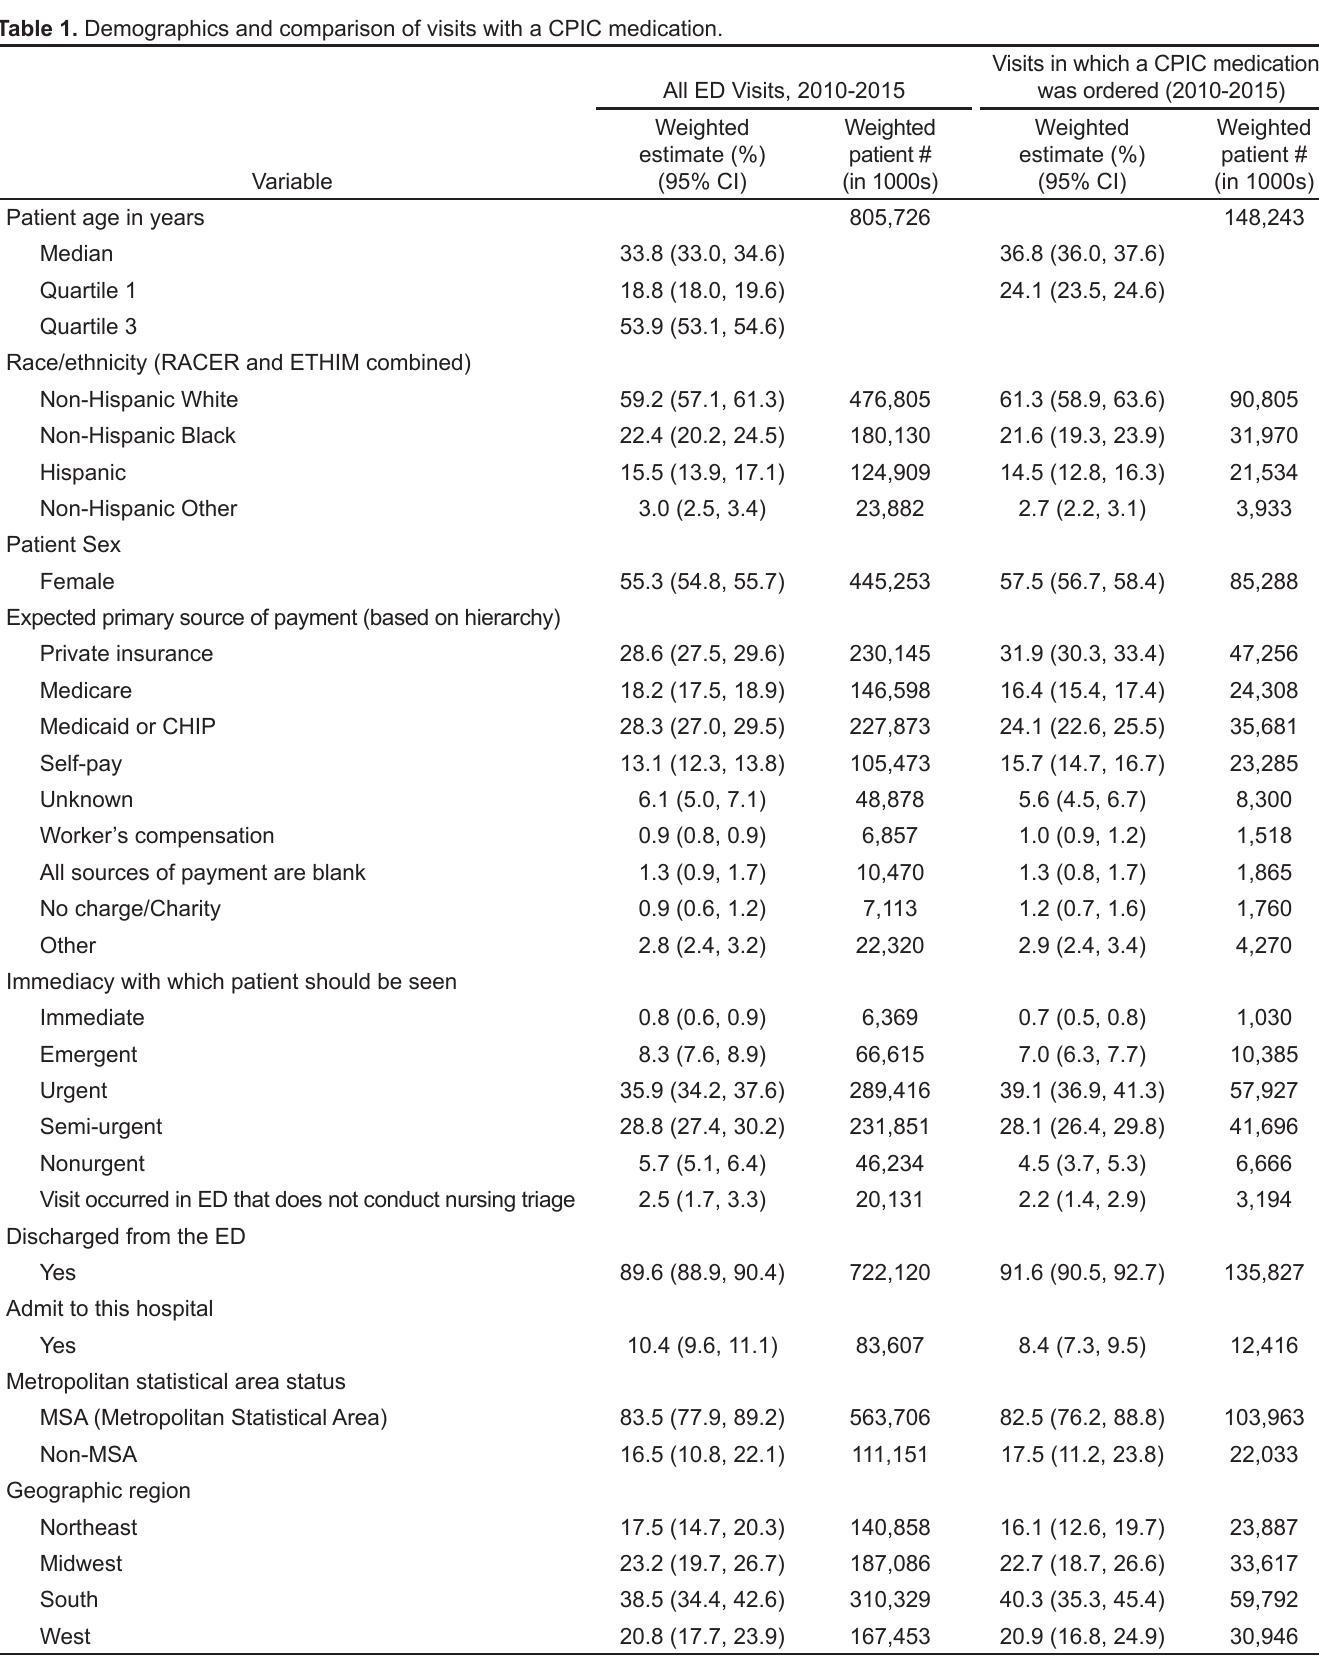
Table 1. Demographics and comparison of visits with a CPIC